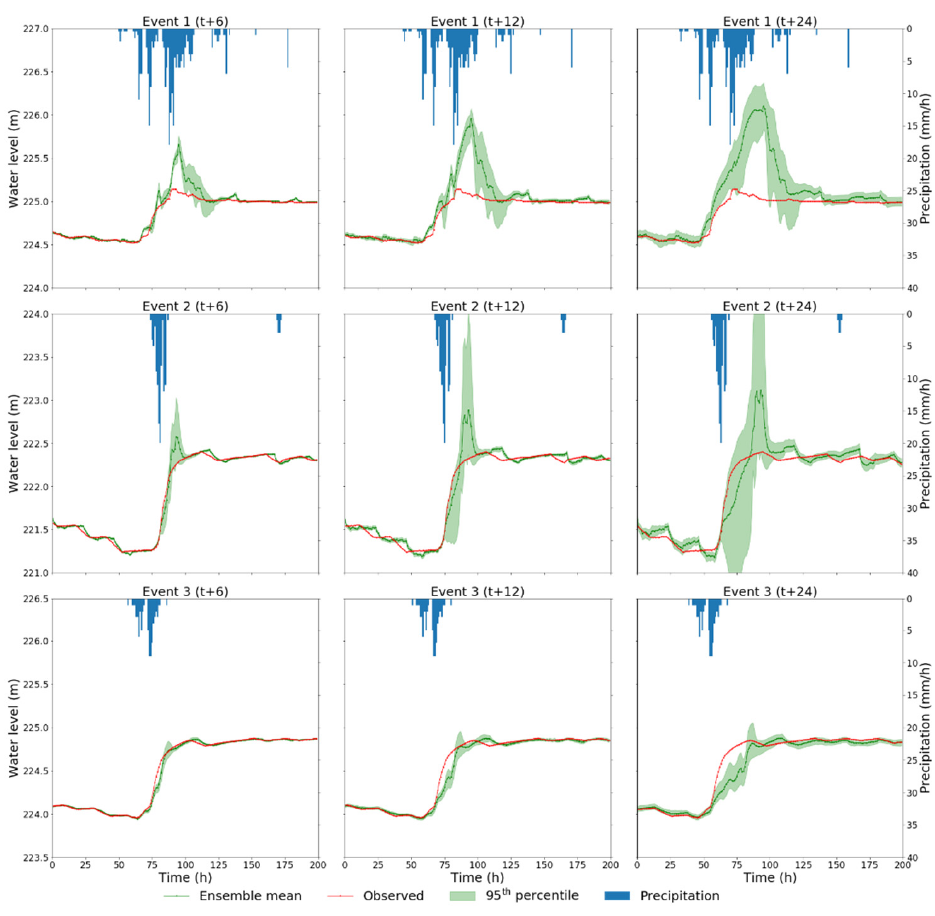
Figure 6. Observed and predicted water levels for the LSTM ED1 simulations at 6, 12, or 24 h in events 1 to 3. The 95th percentiles for the ensemble member predictions are shown with light green